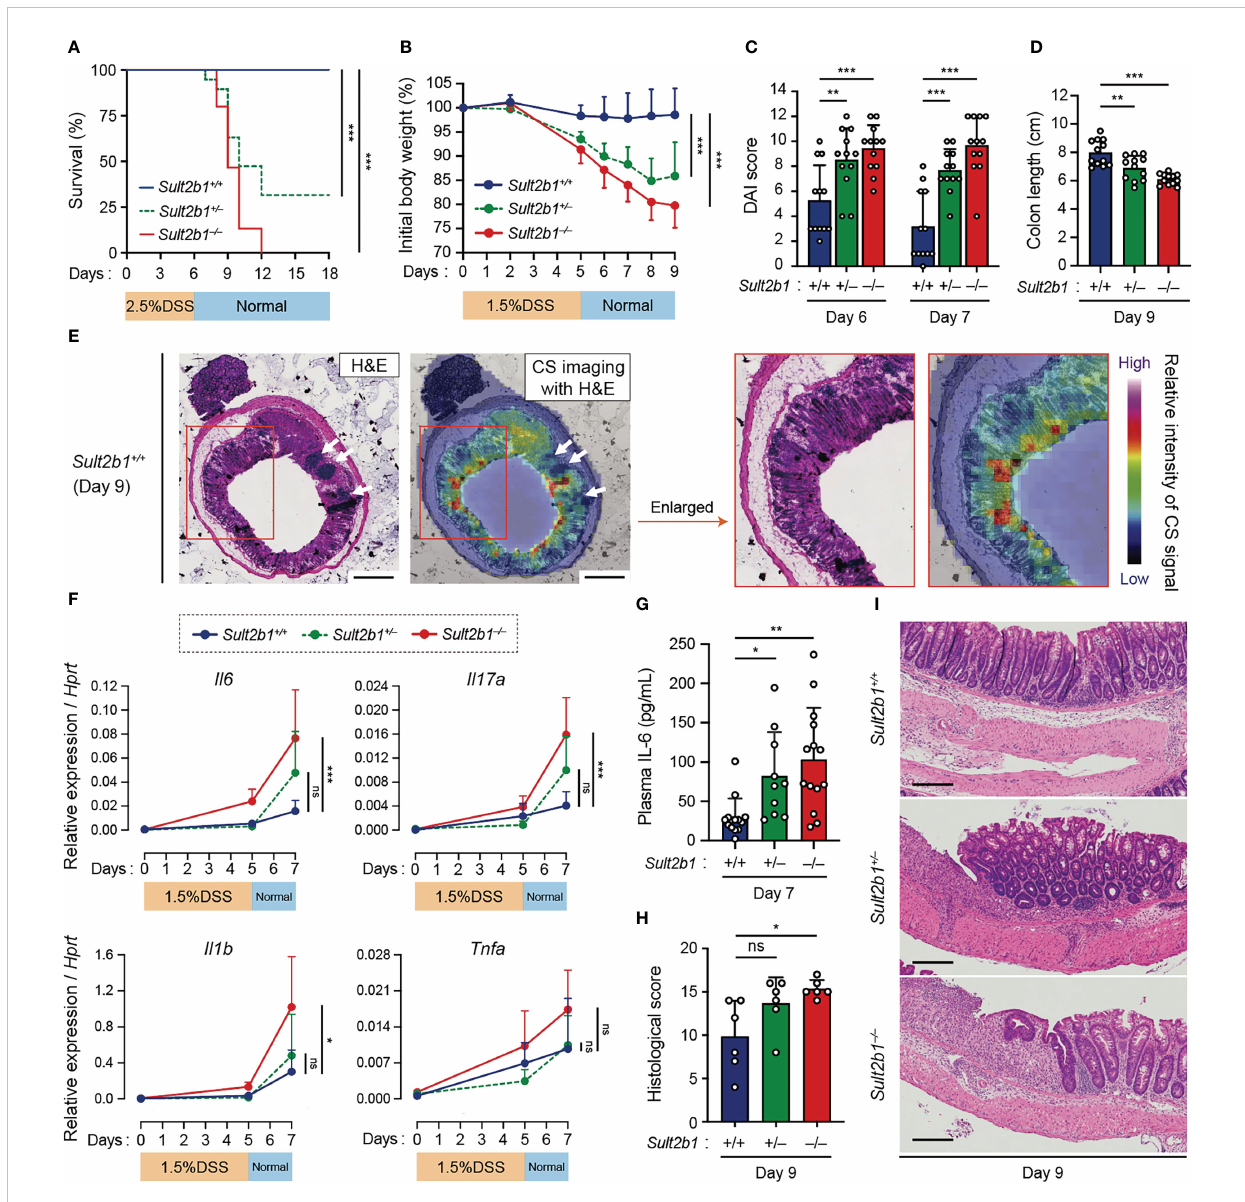
FIGURE 2 CS-de fi cient mice exhibit severe colitis during DSS-induced mucosal injury. (A) Kaplan – Meier cumulative survival curve of Sult2b1 +/+ , Sult2b1 +/ − , and Sult2b1 − / − mice treated with 2.5% DSS in drinking water for 6 days (n = 15, 19, and 15 mice per group, respectively; log-rank test). (B – D) Body weights, DAI scores, and colon lengths of Sult2b1 +/+ , Sult2b1 +/ − , and Sult2b1 − / − mice treated with 1.5% DSS in drinking water for 5 days (n = 12 mice per group; one-way ANOVA with Dunnett ’ s multiple comparison test). (E) CS localization in the colon cross-section from Sult2b1 +/+ mice visualized using H&E staining and MS imaging. Color bar indicates the relative intensities of the CS signal ( m/z 465). White arrows indicate solitary intestinal lymphoid tissues. Enlarged (boxed) areas are shown on the right. Scale bar, 500 m m. (F) Real-time PCR analysis of in fl ammatory gene expression in the entire colon on day 0, 5, and 7 after a 5-day 1.5% DSS challenge (n = 7 mice per group; one-way ANOVA with Dunnett ’ s multiple comparison test). Target gene expression was normalized to Hprt expression. (G – I) Plasma concentrations of IL-6, histological scores, and the representative H&E staining of colon sections from 1.5% DSS-treated mice on days 7 and 9 (n = 7 mice per group; one-way ANOVA with Dunnett ’ s multiple comparison test). Scale bar, 200 m m. Data were obtained from four (A) , three ( B – D and F – I ), and two (E) independent experiments, and graphs are shown as the mean ± SD. * P < 0.05; ** P < 0.01; *** P < 0.001; ns, not signi fi